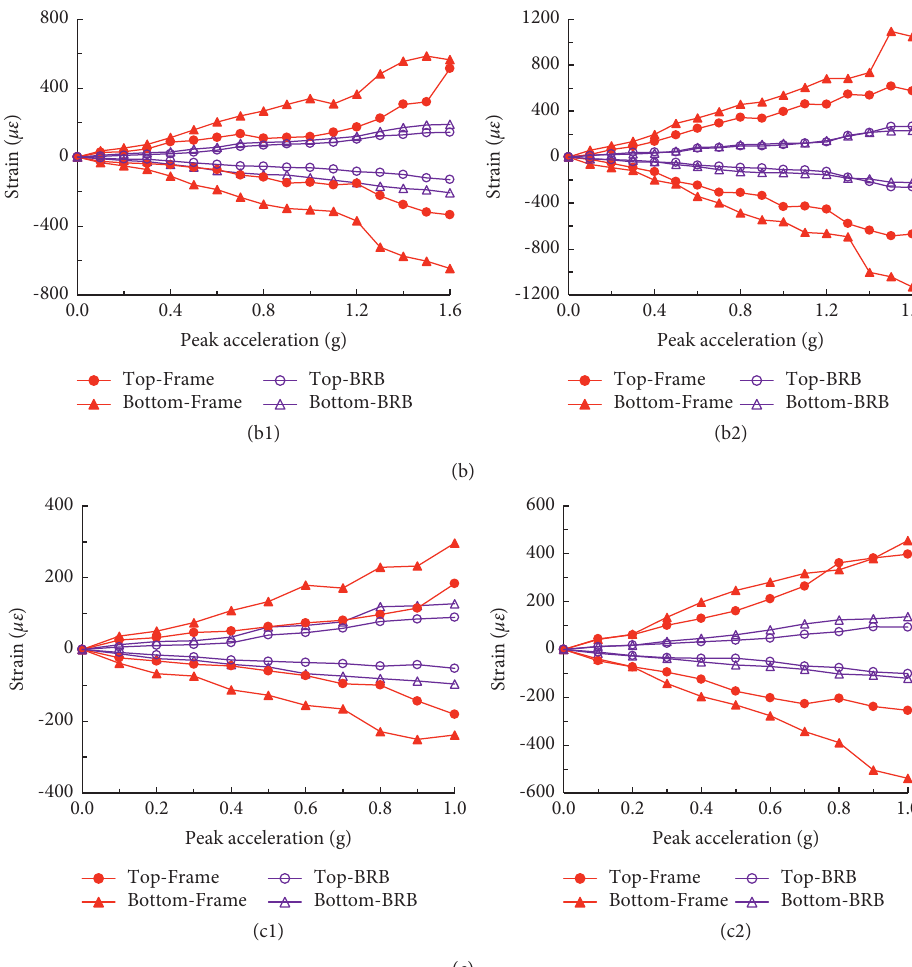
Figure 19: Comparison of maximum strains for these two specimen under different earthquake waves. (a) El Centro wave. (a1) Column. (a2) Beam. (b) Kobe wave. (b1) Column. (b2) Beam. (c) Taft wave. (c1) Column. (c2) Beam.